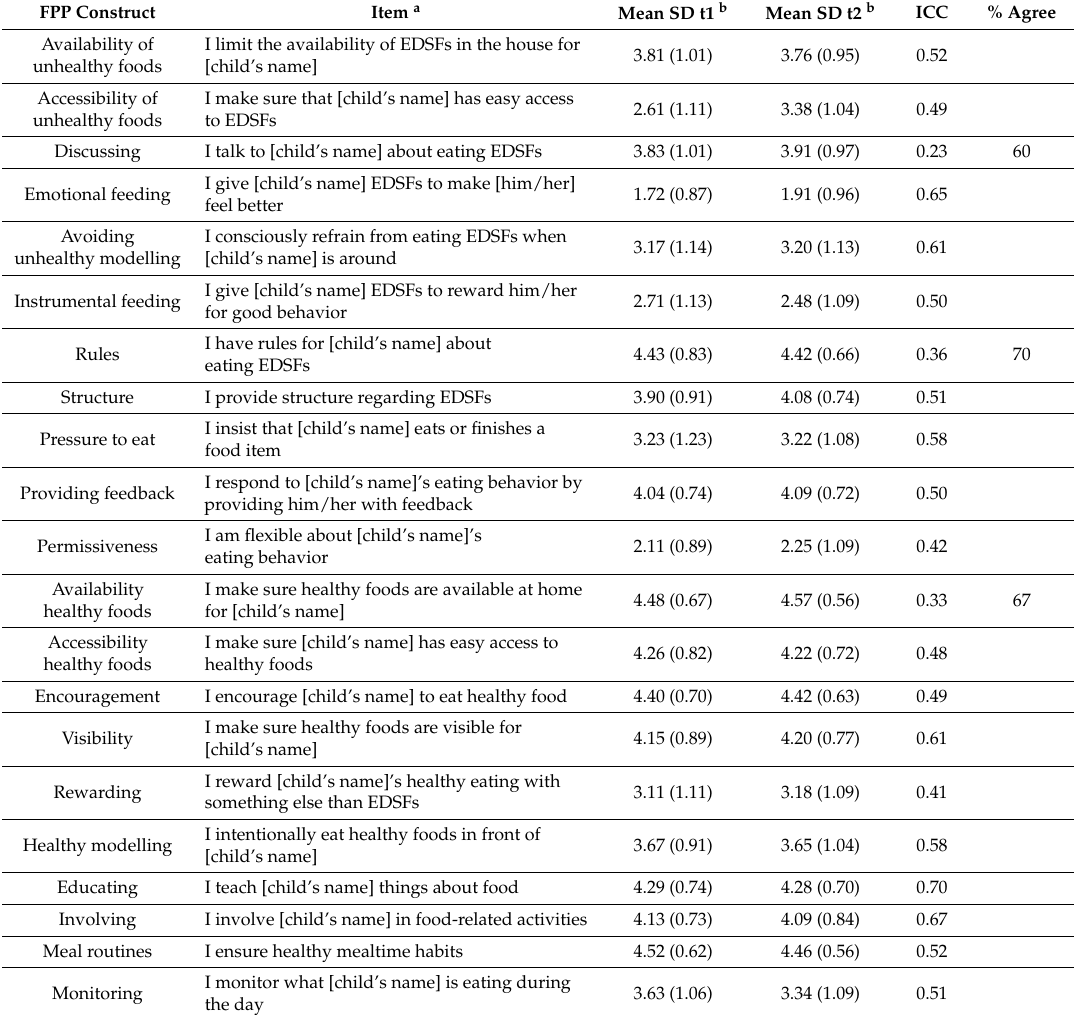
Table 2. Test-retest reliability characteristics of the CSPQ ( n =